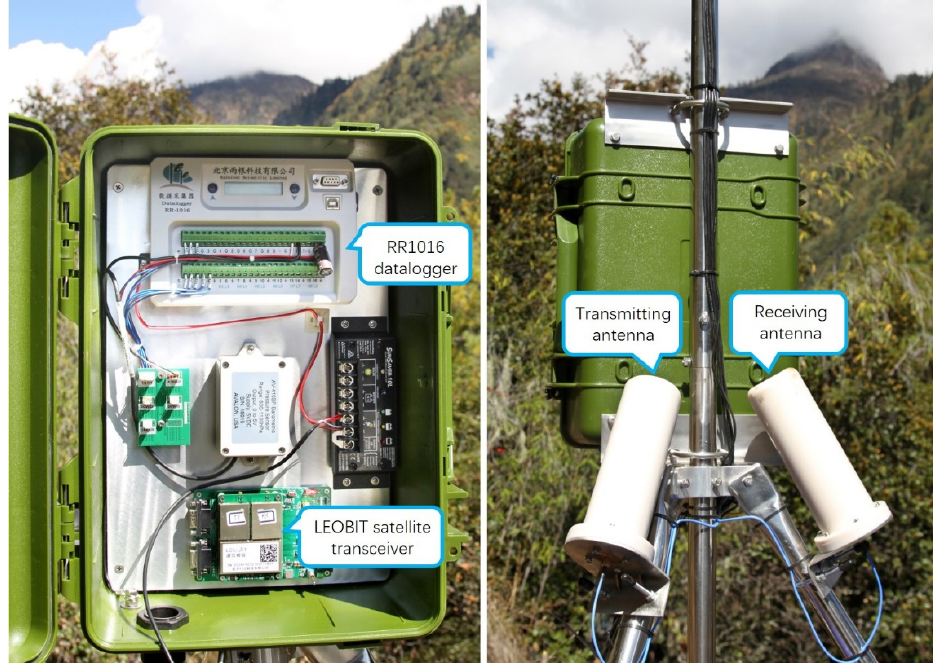
Figure 2. Prototype of the ground IoT terminal device for the Xingyun satellite IoT. The key components of the terminal device include a LEOBIT satellite transceiver, transmitting and receiving antennas, and RR1016 datalogger.